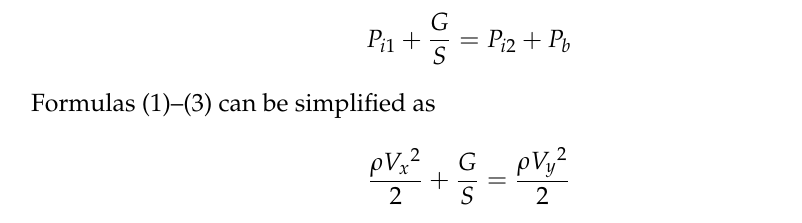
Figure 2. Inner and outer domain meshing: ( a ) simulation of the internal and external domains; ( b ) mesh division.